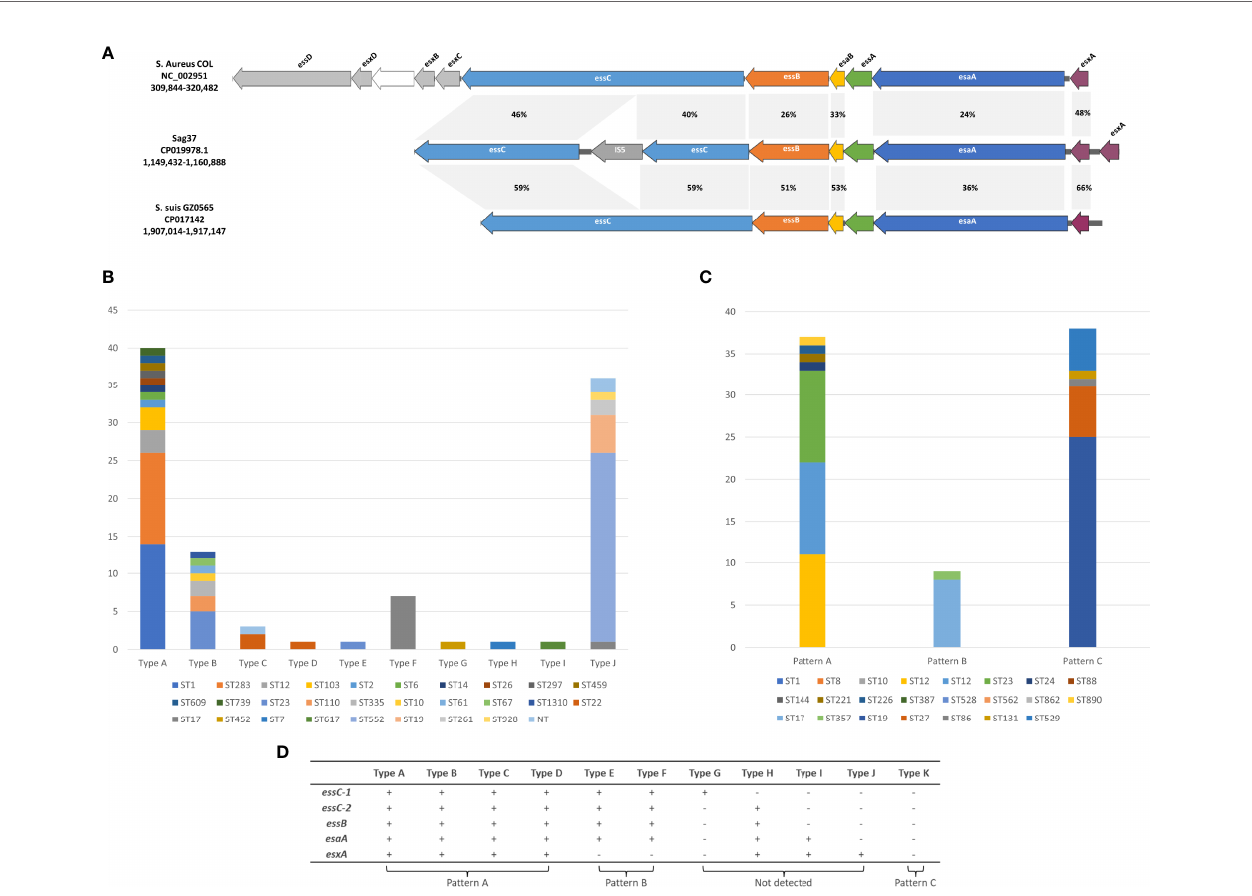
FIGURE 1 | (A) Schematic representation of the T7SS gene clusters in S. agalactiae strain Sag37. Homology analysis and comparison against the corresponding clusters in different species including Staphylococcus aureus COL and Streptococcus suis GZ0565 is also indicated. Related genes are indicated by the same color and amino-acid identities for each gene are shown in the shaded grey areas. (B) Distribution of T7SS types in GBS isolates derived from the Genbank (Sag37 not included). NT: Non-typeable. (C) Distribution of different patterns of PCR screening in clinical GBS isolates recovered during 2014&ndash;2020. (D) Corresponding relationship between PCR-based patterns and T7SS subtypes retrieved from